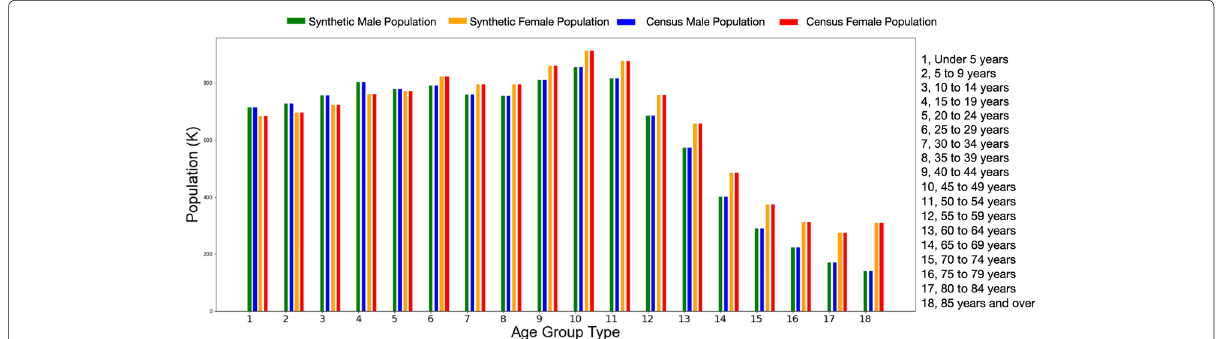
Fig. 6 Verification Results: Comparison between Our Population and Census on Each Age Group’s